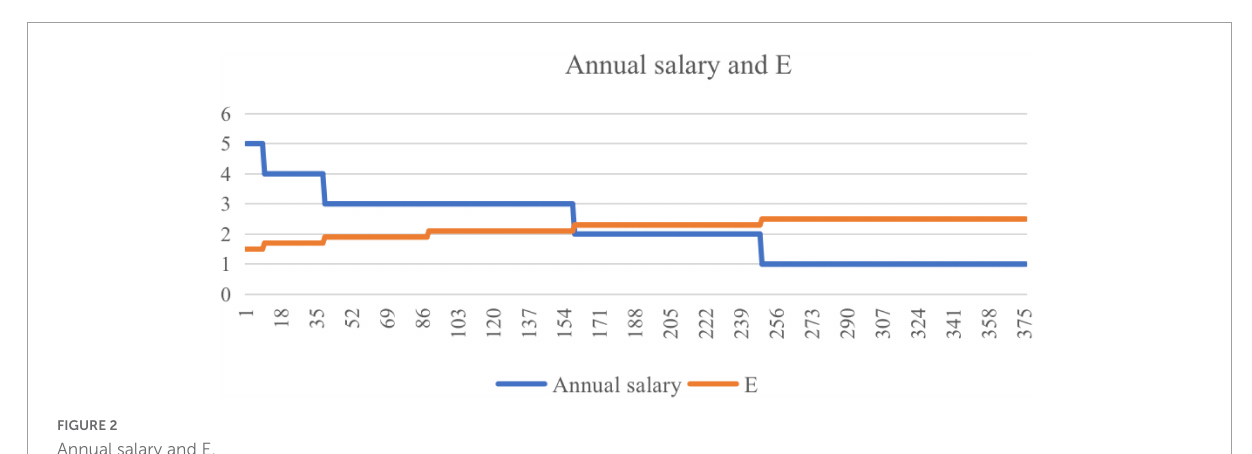
FIGURE2 Annual salary and E.